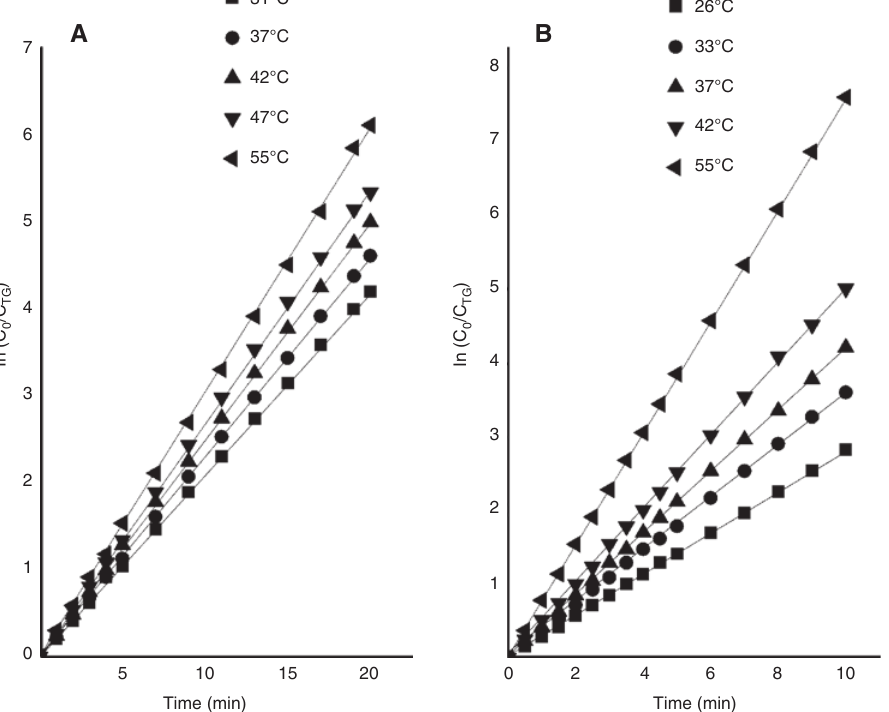
ln C C on t (A) under the CH condition and (B) under the MWHCC condition in different Figure 4: The dependence of ( ) 0 TG